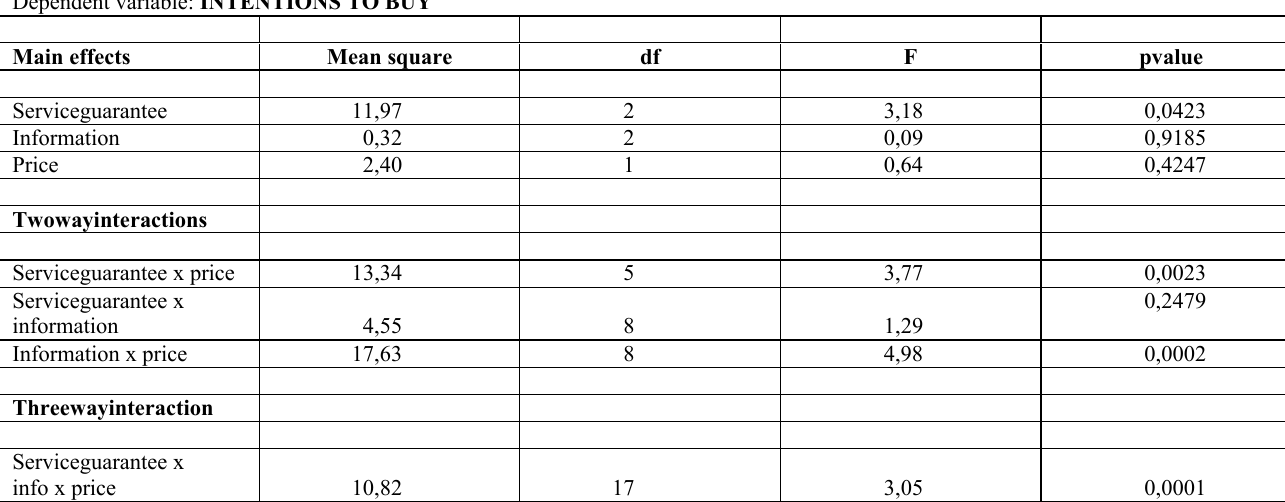
Table 1: Analysis of variance results